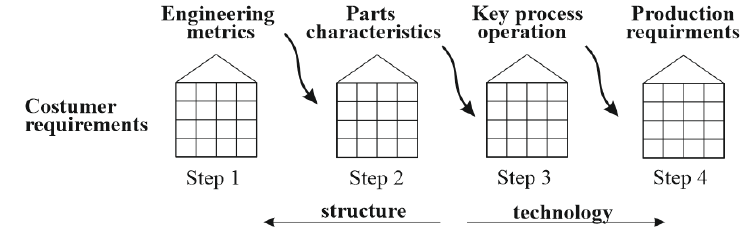
Fig. 6. Stages of the "Quality Factor Deployment" tool .